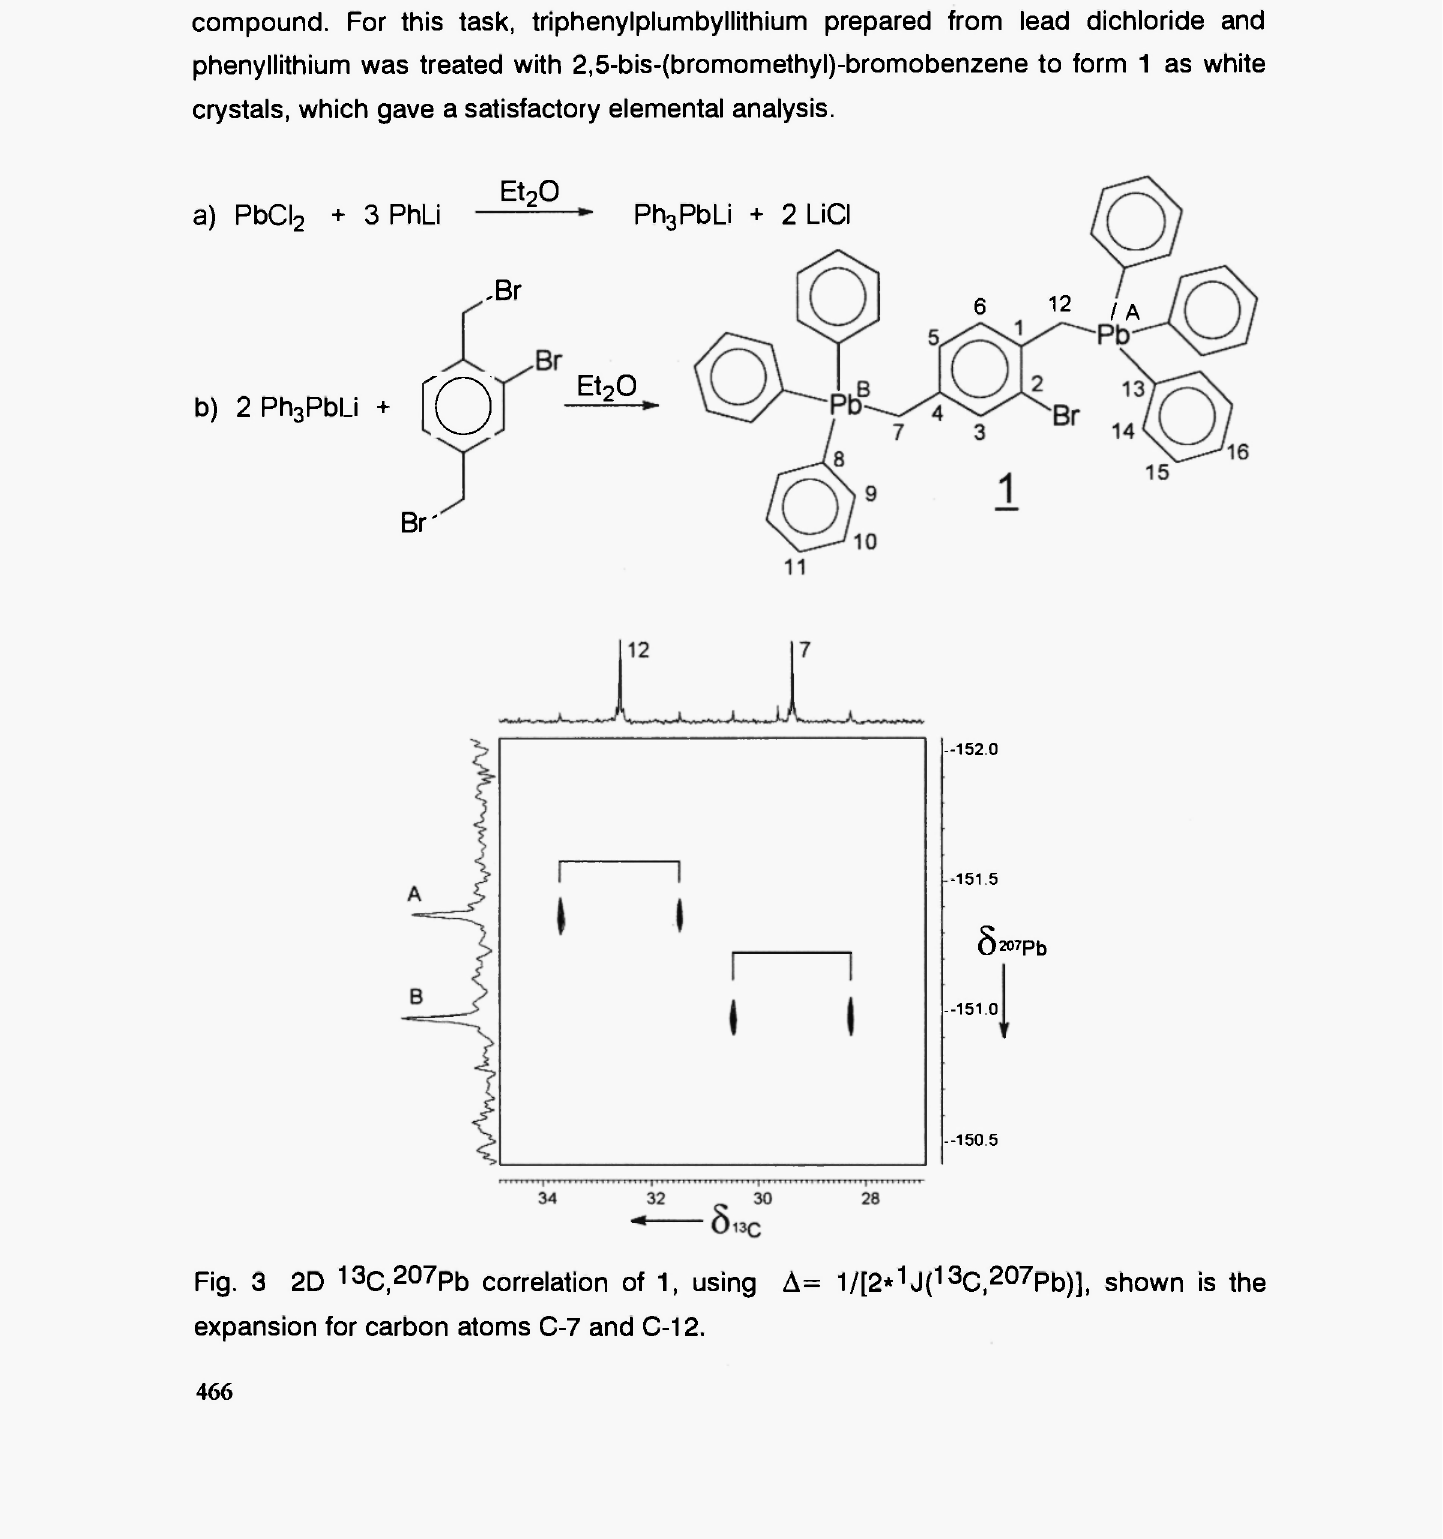
Fig. 3 2D 13 C, 207 Pb correlation of 1, using Δ= 1/[2* 1 J( 13 C, 207 Pb)], shown is the expansion for carbon atoms C-7 and C-12.